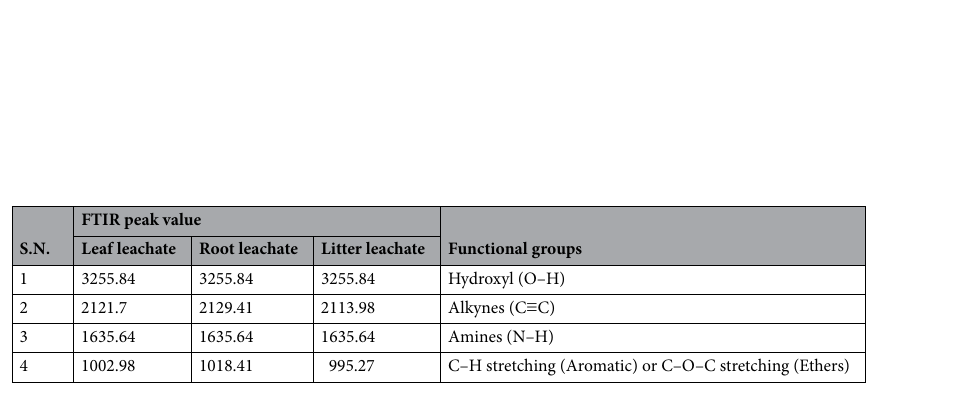
Figure 4. Spectra of IR analysis in A. adenophora fresh leaf, root and litter leachates. The names of the functional groups are given in Table 1.